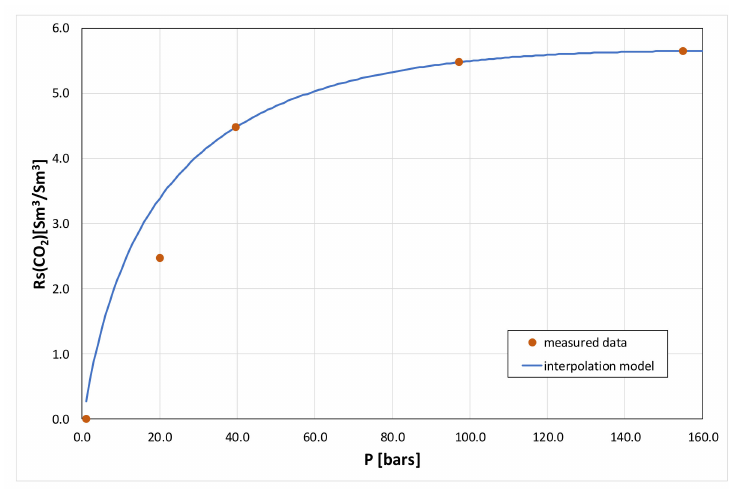
Figure 10. Solution of CO 2 in reservoir brine under reservoir conditions vs. pressure.